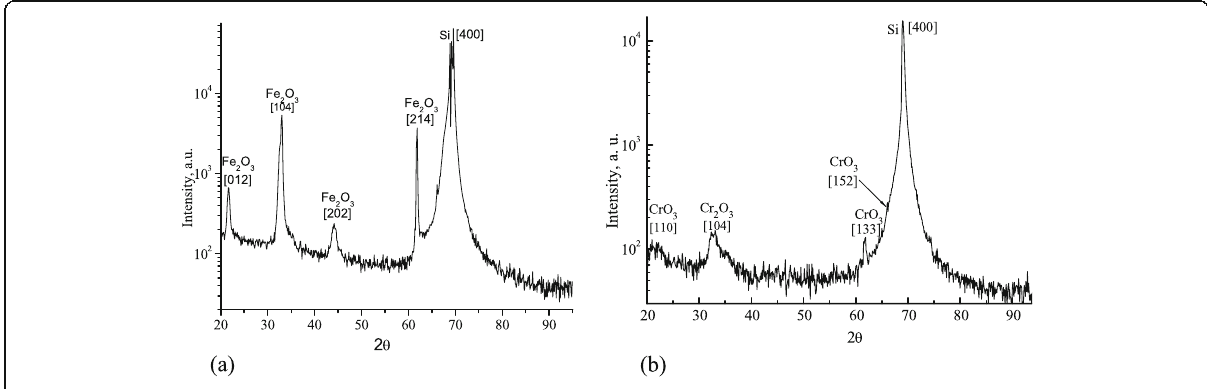
Fig. 1 XRD spectra of nanometric films deposited by RPLD on Si substrate. a Sample #1 Fe 2 O 3 − X . b Sample #2 Cr 3 − X O 3 − Y